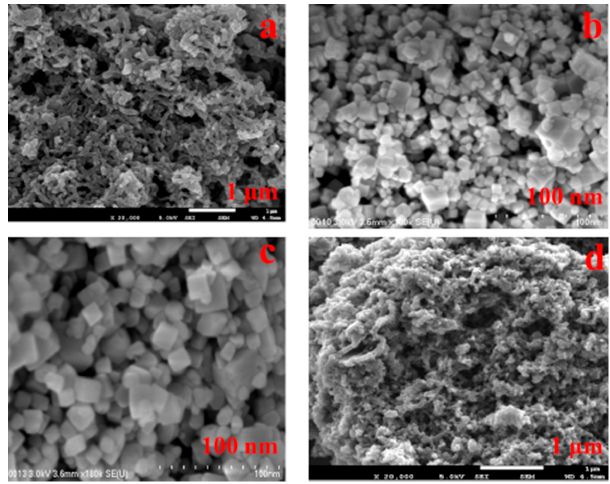
Figure 1. FESEM micrographs of ( a ) polyaniline (PANI), ( b , c ) SrTiO 3 and ( d ) P-Sr500.